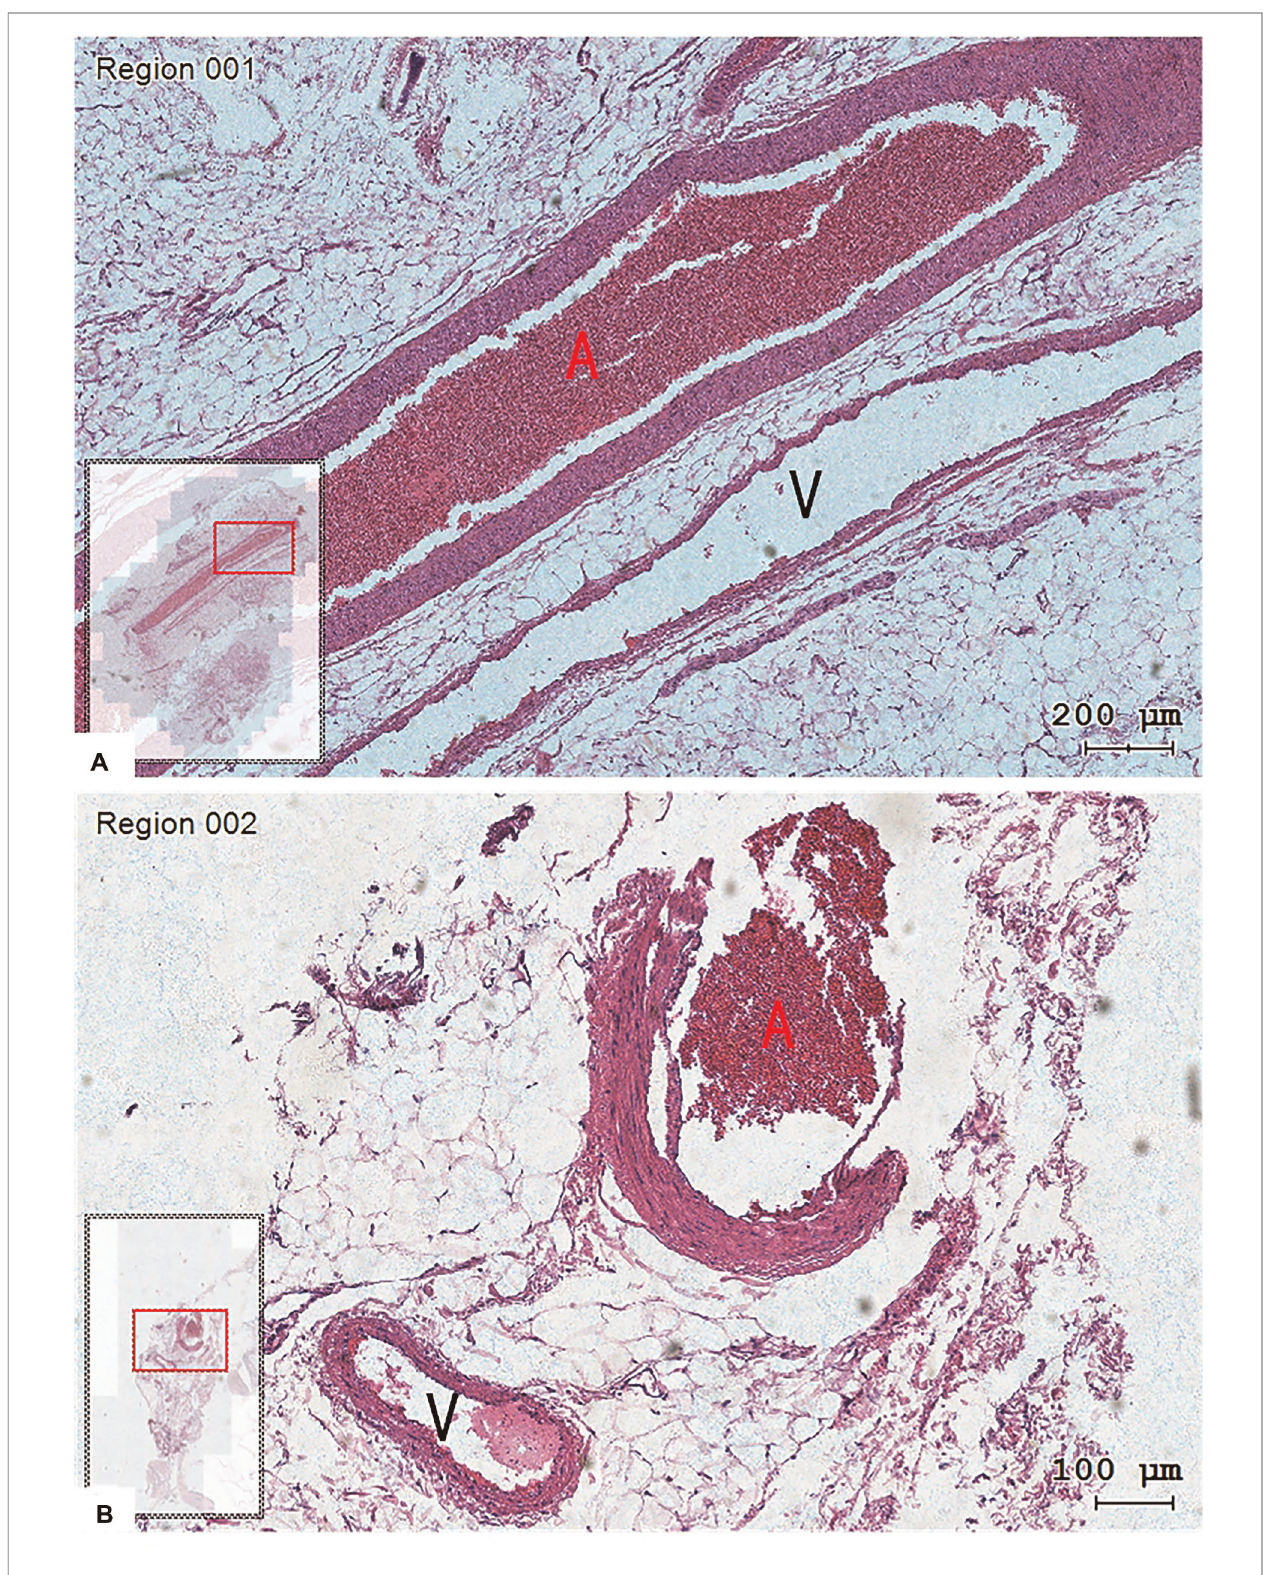
FIGURE 4 | The structure of the arteriovenous wall could be observed in tissue slices, and the vein (V) run closely with the artery (A). ( A ) Coronal plane and ( B ) transverse plane. Hematoxylin-eosin staining, magni fi cation 200× ( A ) and 100× ( B ).